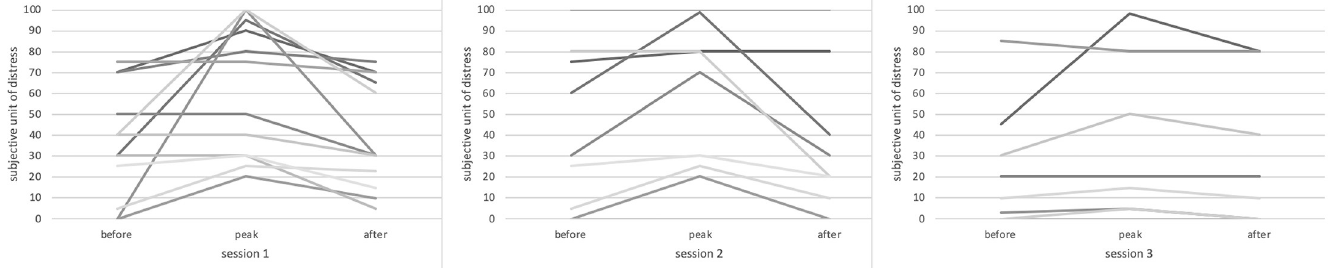
Fig 3. Individual subjective units of distress ratings across the intervention sessions. A decrease in the participants’ mean subjective level of distress during the intervention is seen (session 1 –pre-SUD 35, peak-SUD 61, post-SUD 40; session 2 –pre-SUD 42, peak-SUD 56, post-SUD 33; session 3 –pre-SUD 24, peak-SUD 33, post-SUD